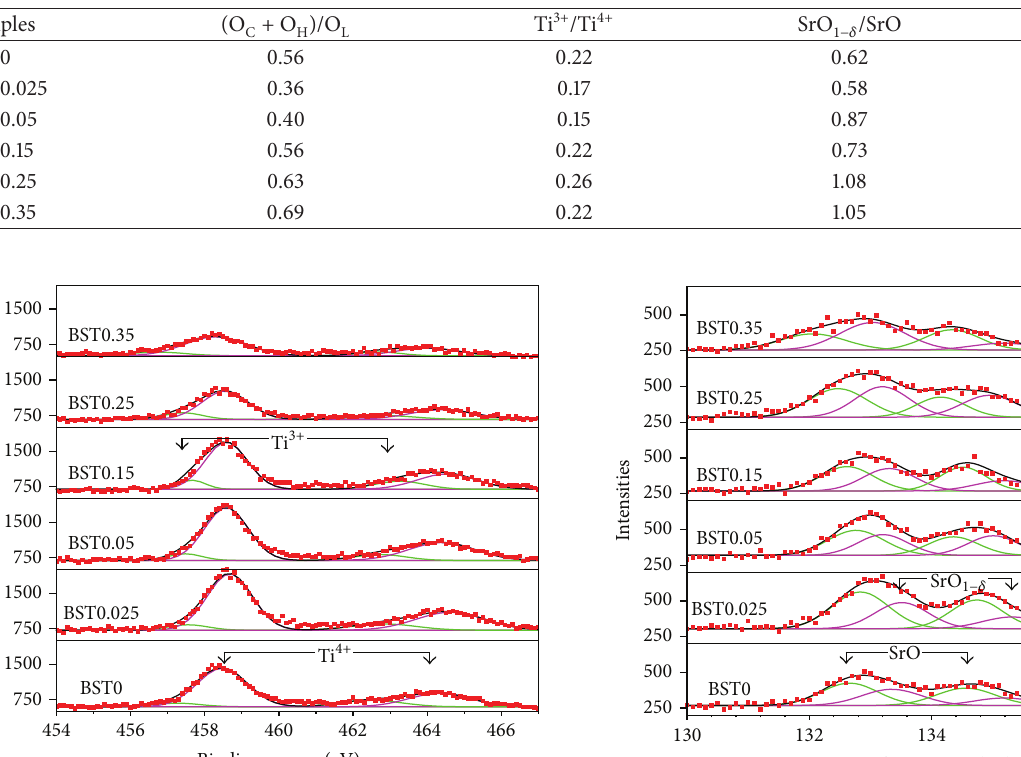
indicating the A-site of Sr atom formed the oxygen deficient more than A-site of Ba